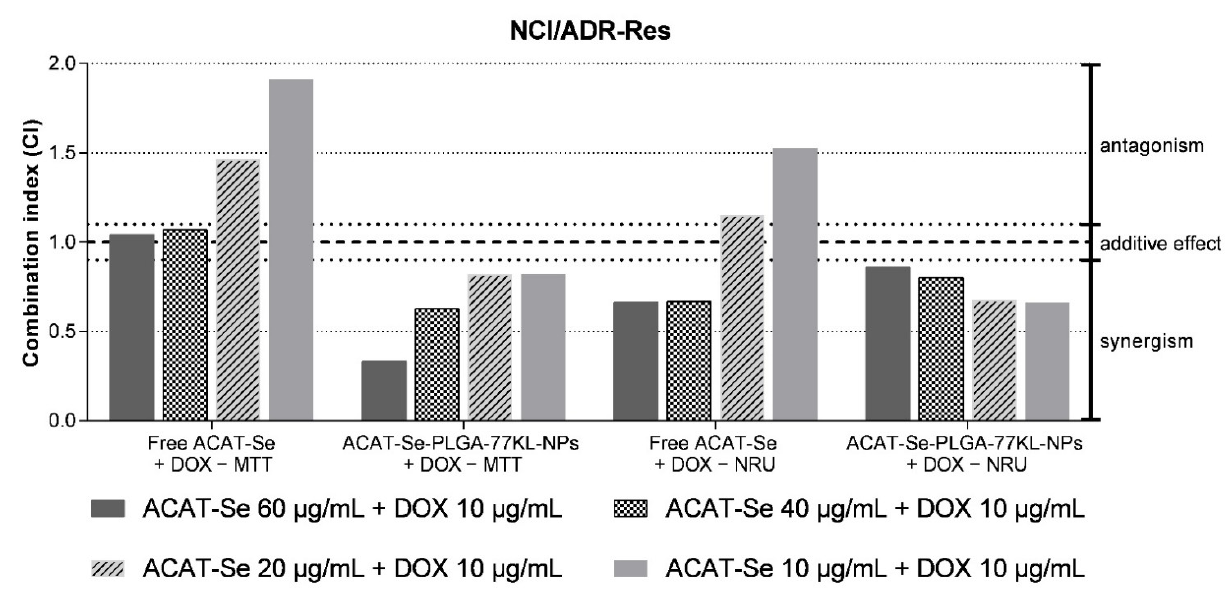
Figure 9. Combination index values for association of free ACAT-Se or ACAT-Se-PLGA-77KL-NPs with DOX in MCF-7 and NCI/ADR-Res cell lines.